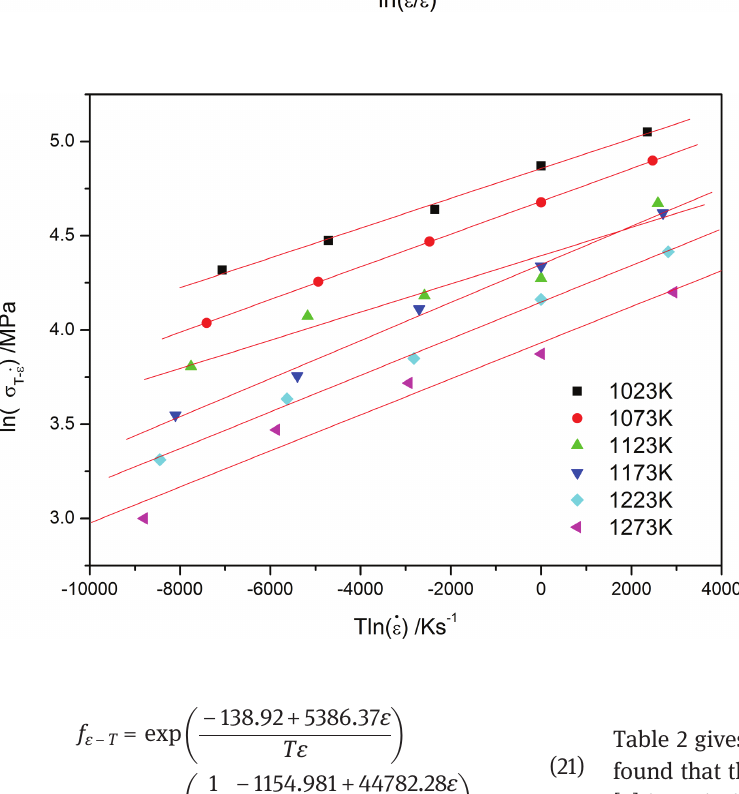
Figure 10: Relationship between ln ð (cid:2) σ ε − _ ε Þ and ln ð ε = _ ε Þ .